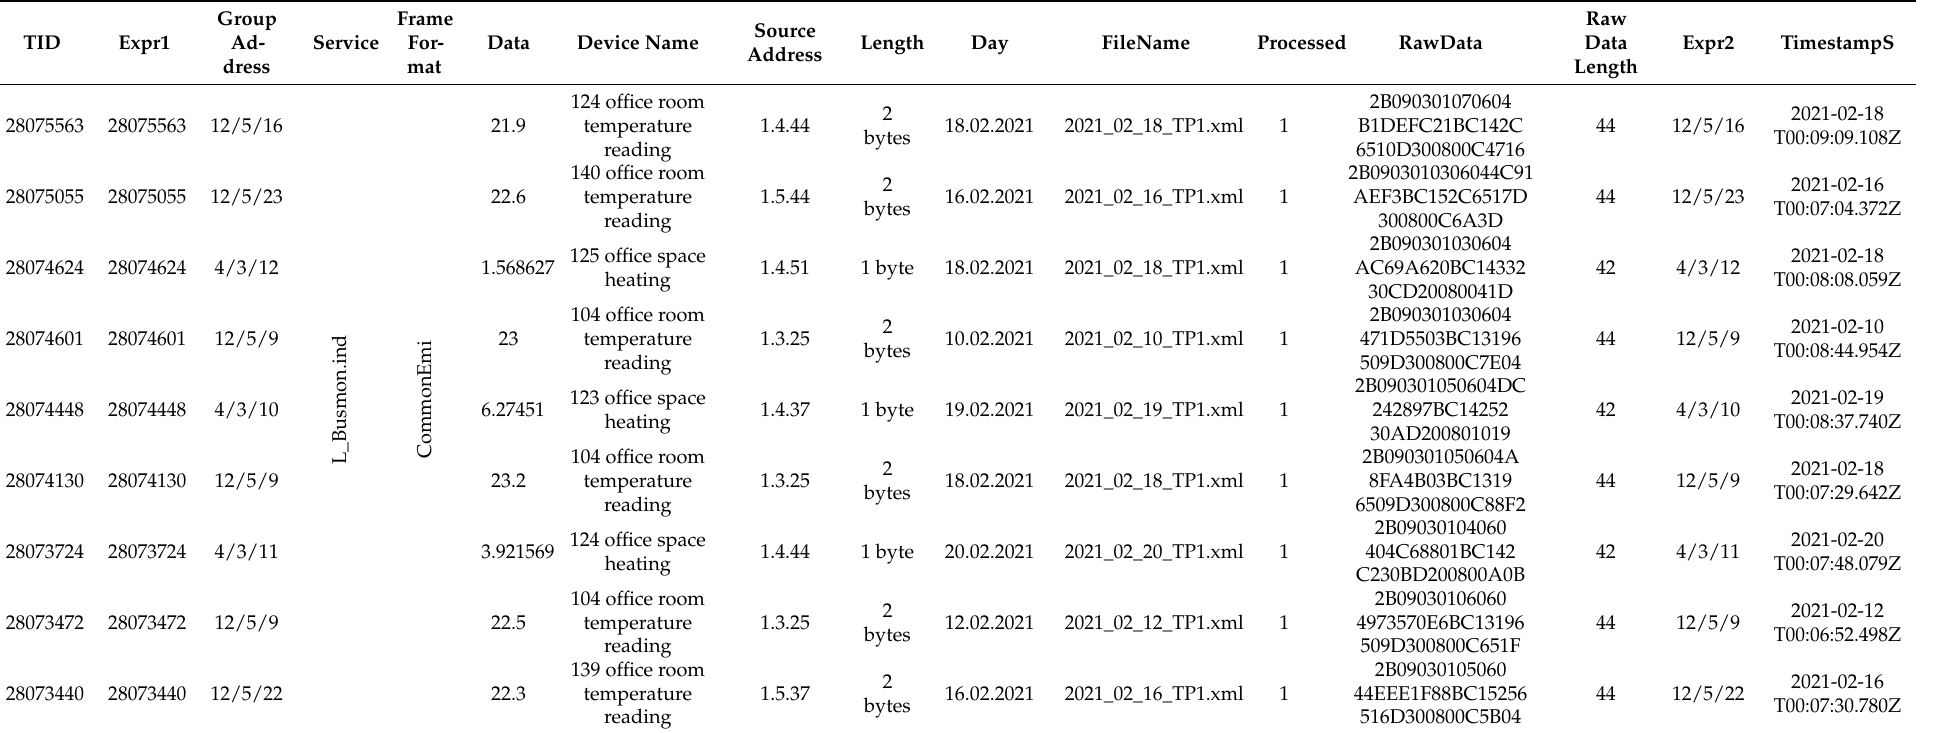
Table 5. Sample data